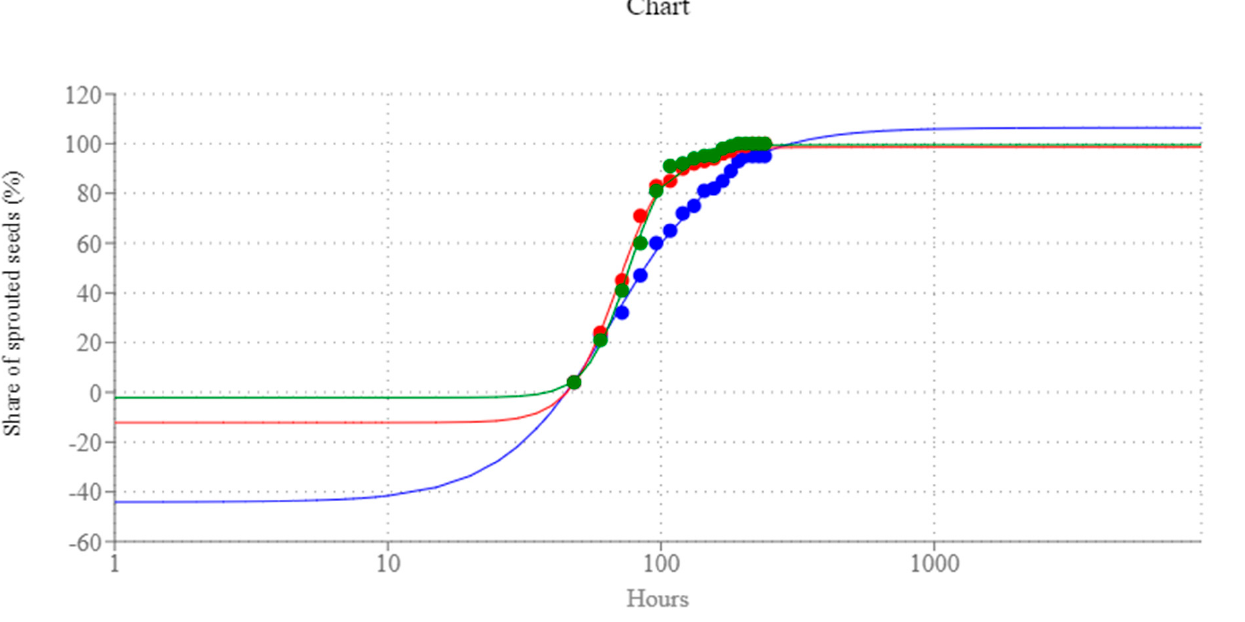
Figure 4. Bean seed germination rate (2015–2017). Control object (blue dot)—the seeds without stimulation of FM; Exposition I (red dot)—the seeds were stimulated FM for 15 seconds; Exposition II (green dot)—the seeds were stimulated FM for 30 seconds.